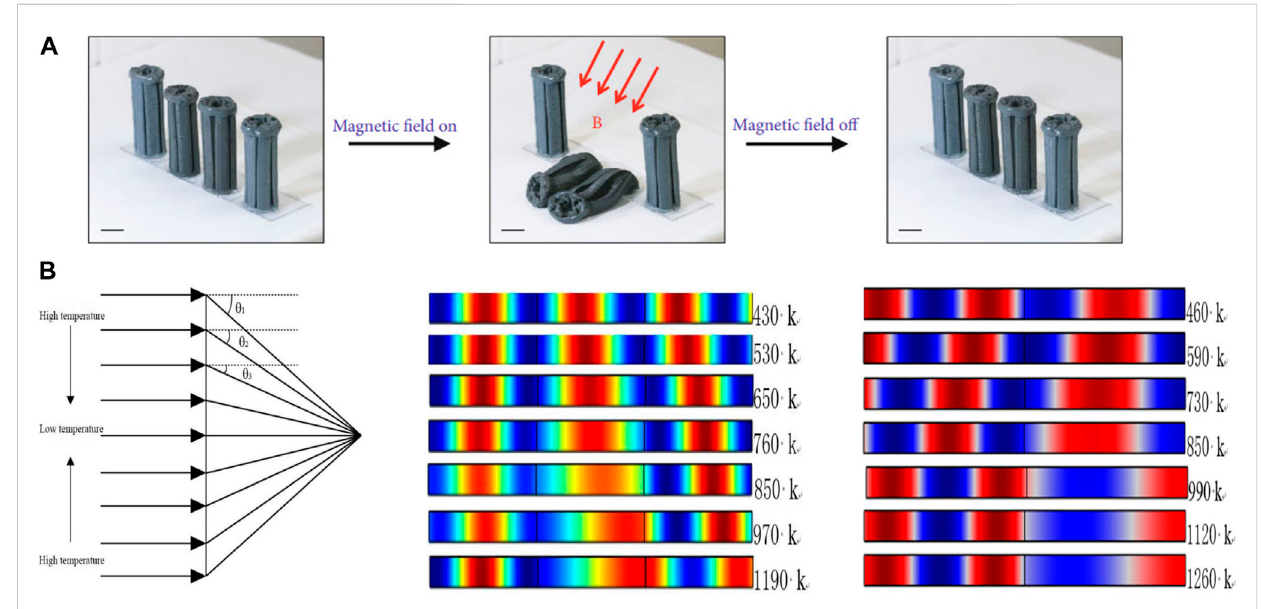
FIGURE 5 Examples of fi eld-responsive material. (A) Acoustic transmission of samples, vertical Mie resonator pillar array (left), pillar array with two pillars bent by a magnetic fi eld (middle), and pillar array when the magnetic fi eld is turned off (right) (Lee et al., 2020). (B) Schematic diagram of temperature- controlled focusing system (left), acoustic pressuredistributionoftransmission unitatdifferenttemperatures(middle), andacoustic pressure distribution of plane wave in seven re fl ection units at different temperatures (Wu et al.,